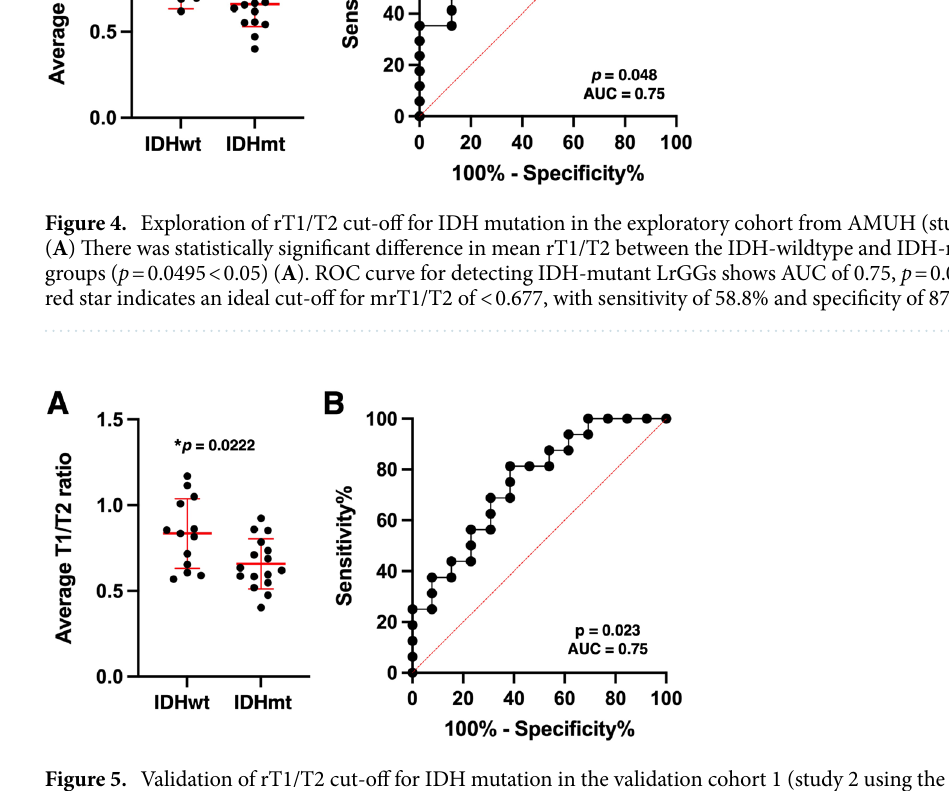
Figure 5. Validation of rT1/T2 cut-off for IDH mutation in the validation cohort 1 (study 2 using the domestic OICI cohort). There was statistically significant difference in mean rT1/T2 between the IDH-wildtype and IDH-mutant groups ( p = 0.022, p < 0.05) ( A ). ROC curve for detecting IDH-mutant LrGGs shows AUC of 0.75, p = 0.023 (p < 0.05), with sensitivity of 56.3% and specificity of 69.2% ( B